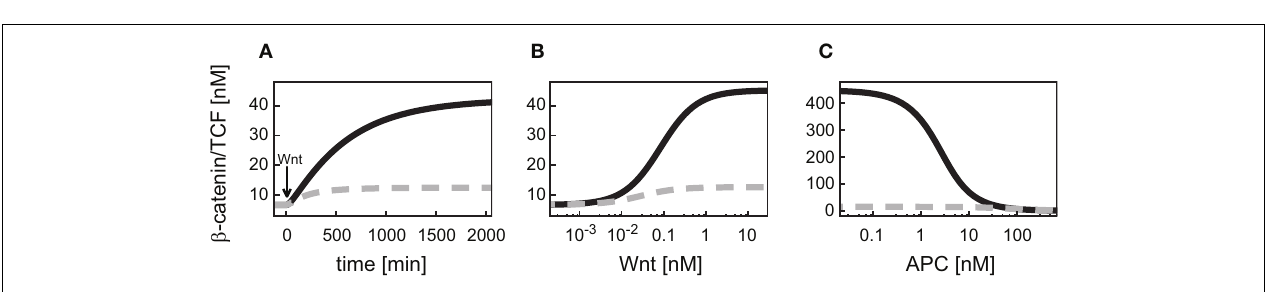
FIGURE 2 | Comparison of the dynamical properties of β -catenin in the minimal and the detailed model. (A) Time courses of β -catenin in response to a constantWnt stimulation. (B,C) Steady states of β -catenin for different